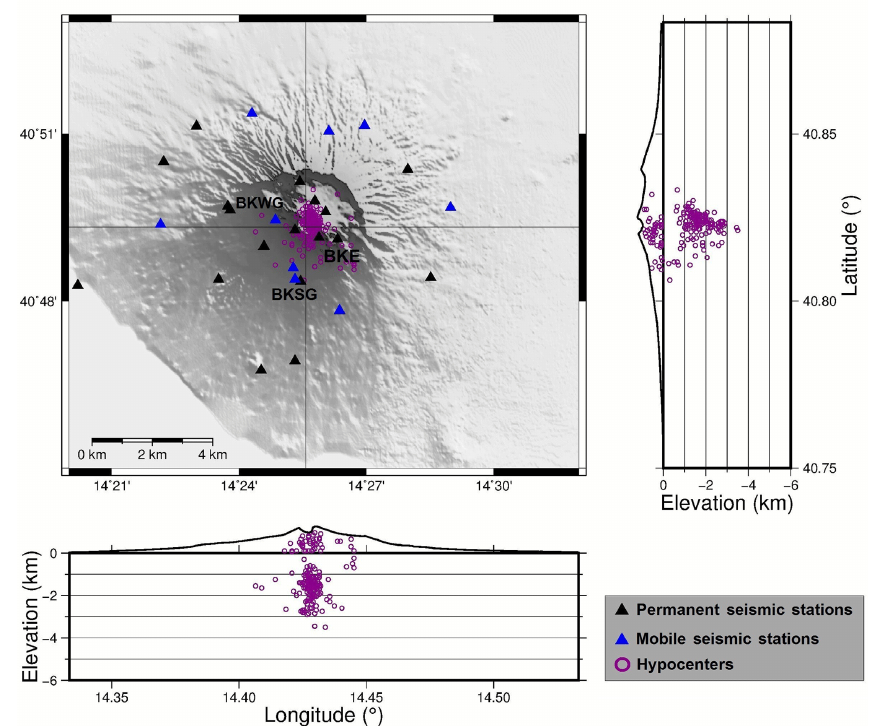
Figure 1. Locations of the typical VTs (purple circles) of Mt. Vesuvius for the time range 2003–2018, plotted on the horizontal plane (upper-left), and the EW (lower-left) and NS (right) sections. The shown locations are the high quality hypocenters (RMS < 0 . 07) obtained by NLLoc software (Lomax et al., 2000). The permanent (black triangles) and mobile (blue triangles) seismic stations of INGV-OV are